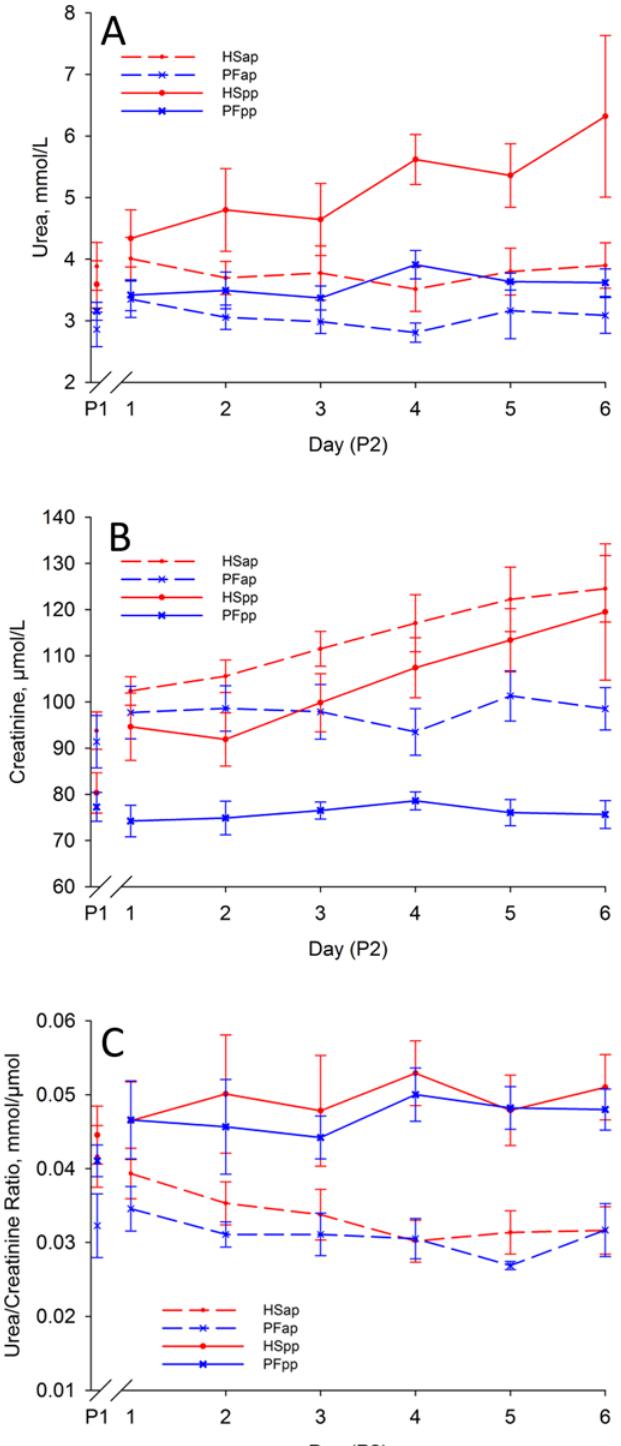
Fig 3. Plasma Urea and Creatinine. Effect of heat stress (HS) and pair-feeding (PF) on (A) plasma urea, (B) plasma creatinine, (C) urea/creatinine ratio. In experimental period 1 (P1) all animals were kept at thermoneutral conditions (THI = 59.7) with ad-libitum feeding for six days. During period 2 (P2), HS cows (red lines) were heat-stressed (THI = 76.1), whereas PF cows (blue lines) were pair-fed in